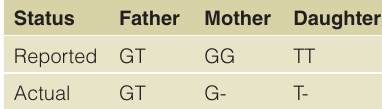
Table 5. Example of hemizygous site reported as homozygous.